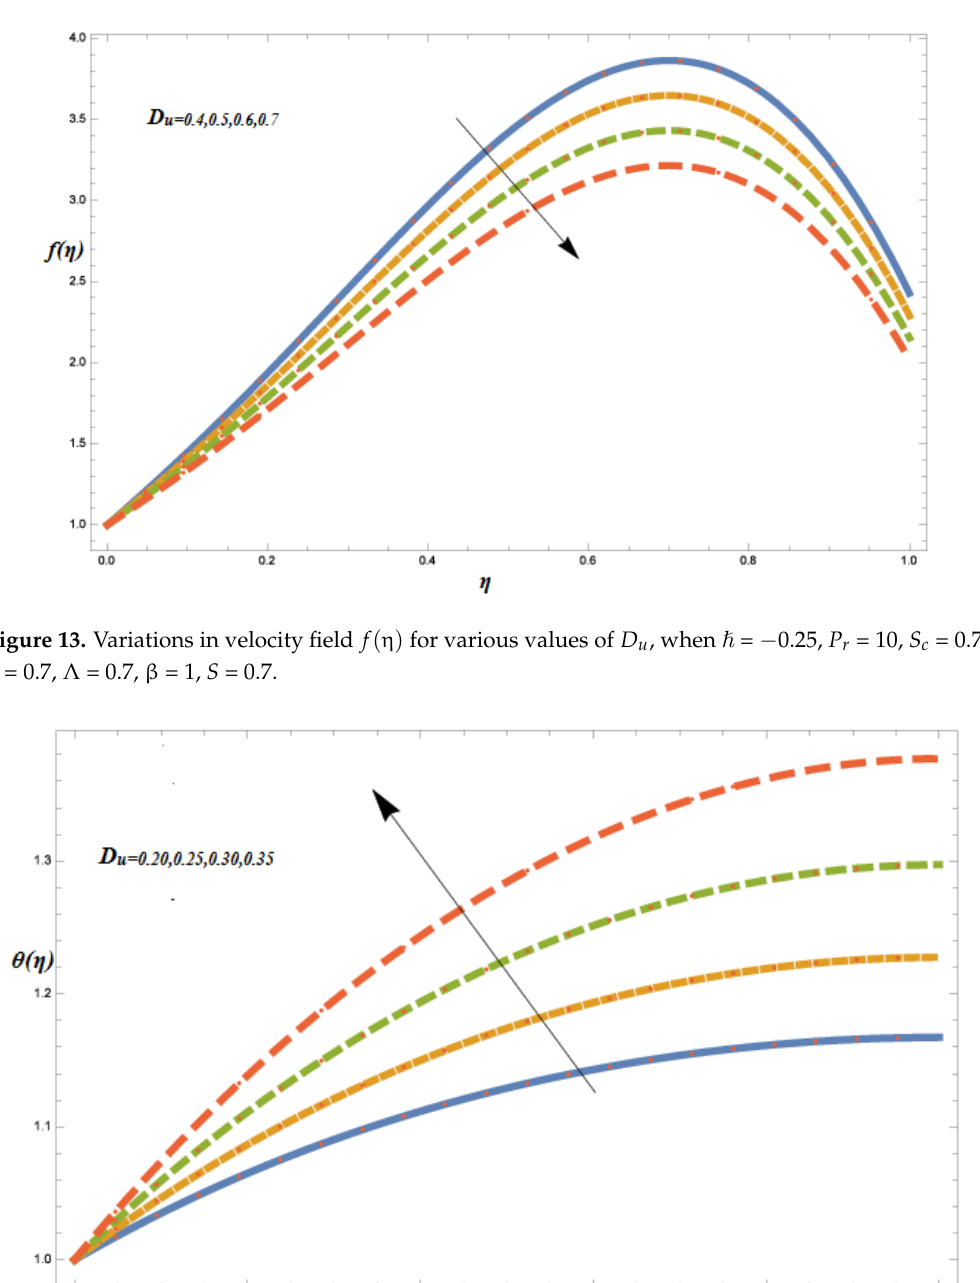
Figure 12. Variations in concentration field ( )   occur for different values of r P , when  = − 0.25,